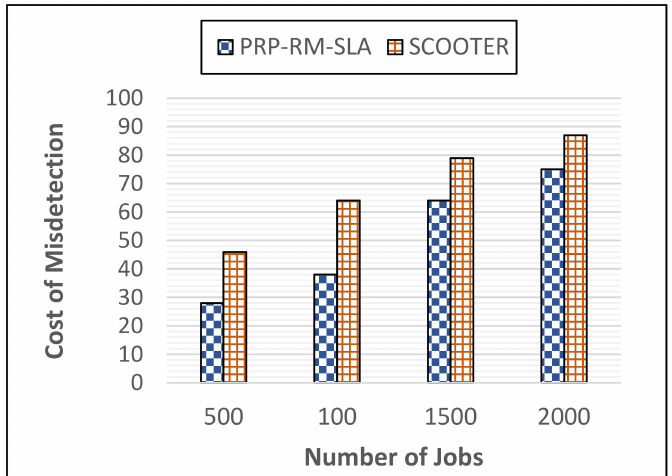
Figure 4. Comparison of results in respect of misdetection